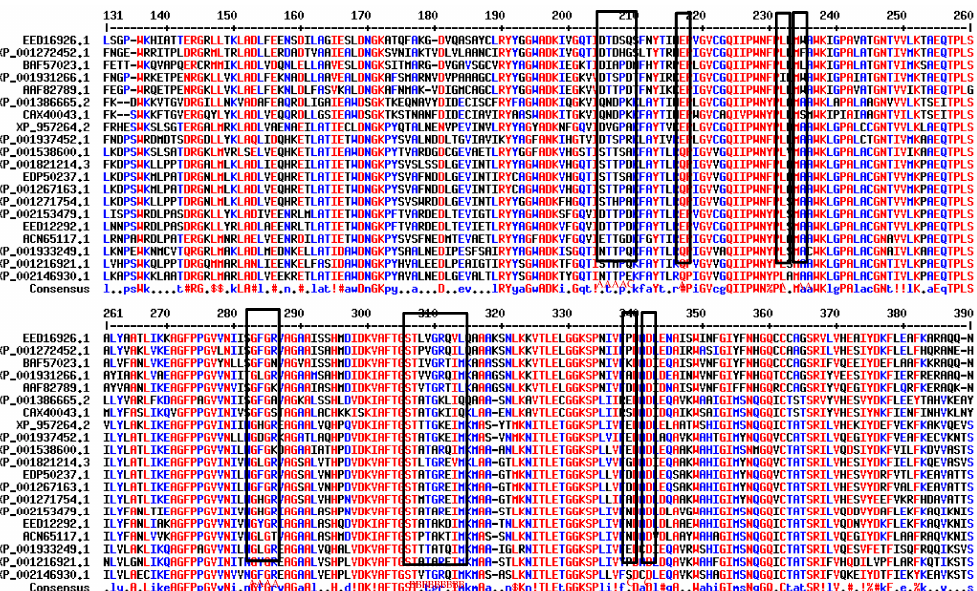
Figure 2. Multiple sequence alignment of conserved domain of aldehyde dehydrogenase from 20 fungal species. All of these aldehyde dehydrogenases are members of the aldehyde dehydrogenase superfamily; their active sites and chemical binding sites are highly conserved. The asterisks refer to the conserved amino acid residues. A: NAD(P) binding site; B: active site; C: active site and NAD(P) binding